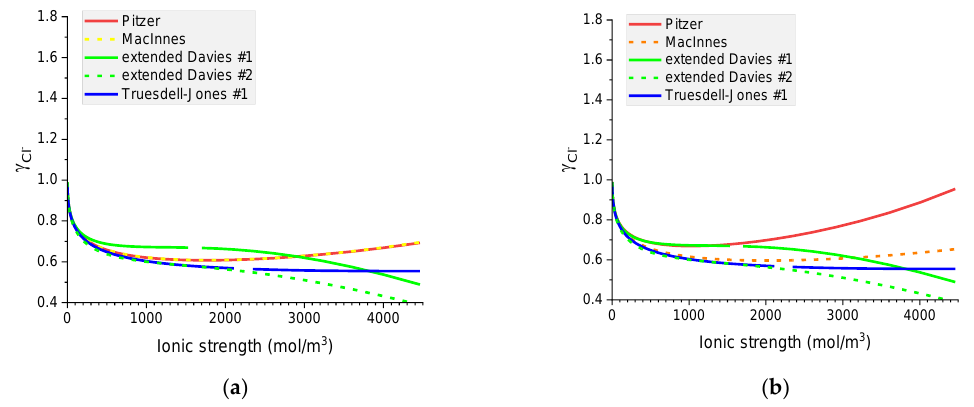
Figure 9. Molar Cl − individual activity coefficients in aqueous ( a ) KCl and ( b ) NaCl solutions. Comparison of calculated activity coefficients based on the Pitzer, MacInnes, extended Davies, and Truesdell – Jones models at 25 °C.